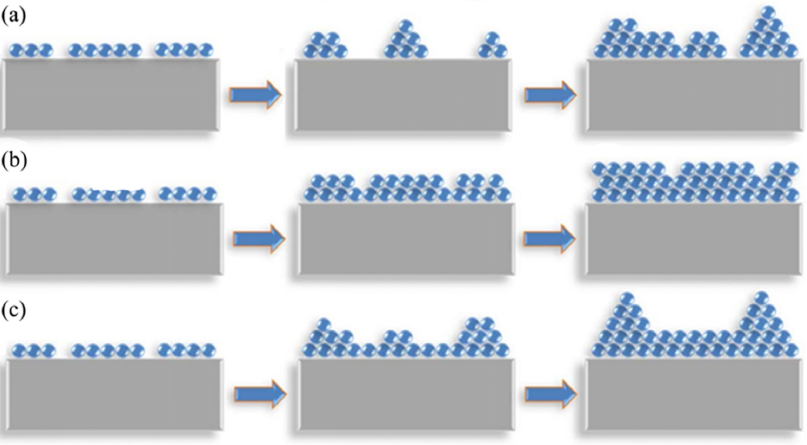
Figure 3. Schematic representation of three growth modes. ( a ) Island growth mode, or Volmer–Weber growth mode; ( b ) layer-by-layer growth mode, or Frank van der Merwe growth mode; ( c ) layer plus island growth mode, or Stranski–Krastanovs growth mode. Reprinted with permission from [46] 2010 Elsevier